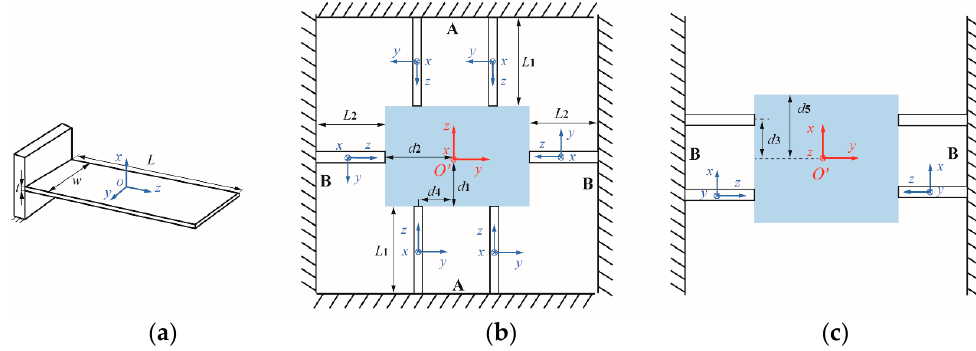
Figure 10. Coordinate systems of the slender beams: ( a ) local coordinate; ( b ) upper view of global coordinate; ( c ) front view of global coordinate.